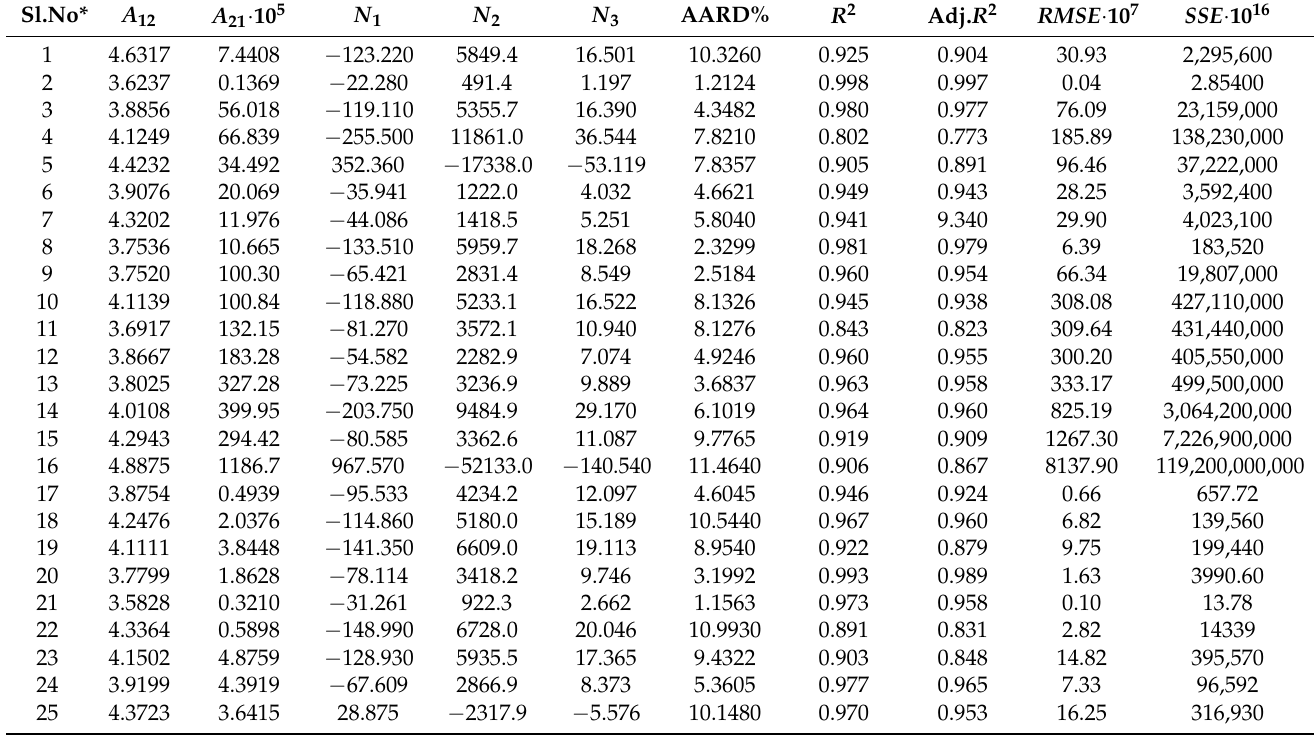
Table 4. Correlation constants of the new model 1 (Equation